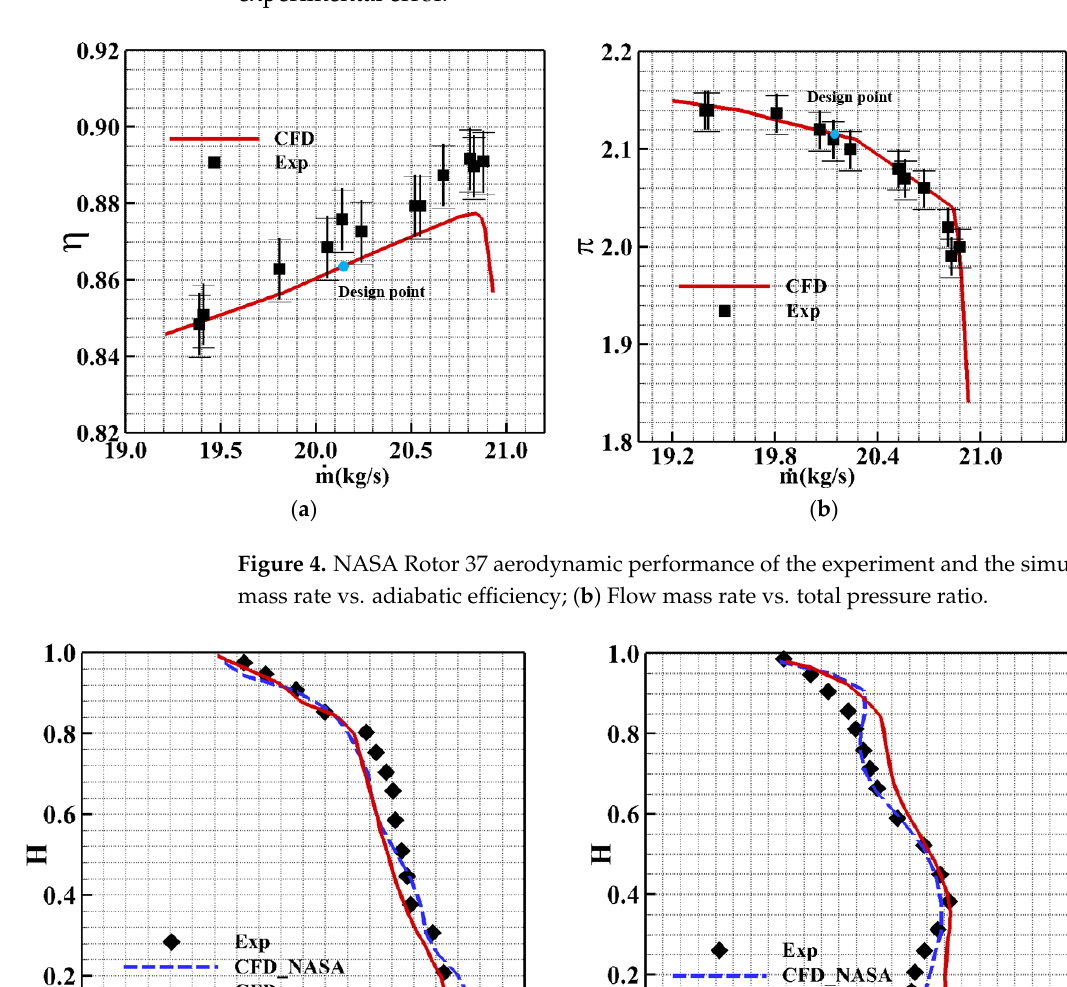
Figure 4. NASA Rotor 37 aerodynamic performance of the experiment and the simulation. ( a ) Flow mass rate vs. adiabatic efficiency; ( b ) Flow mass rate vs. total pressure ratio.